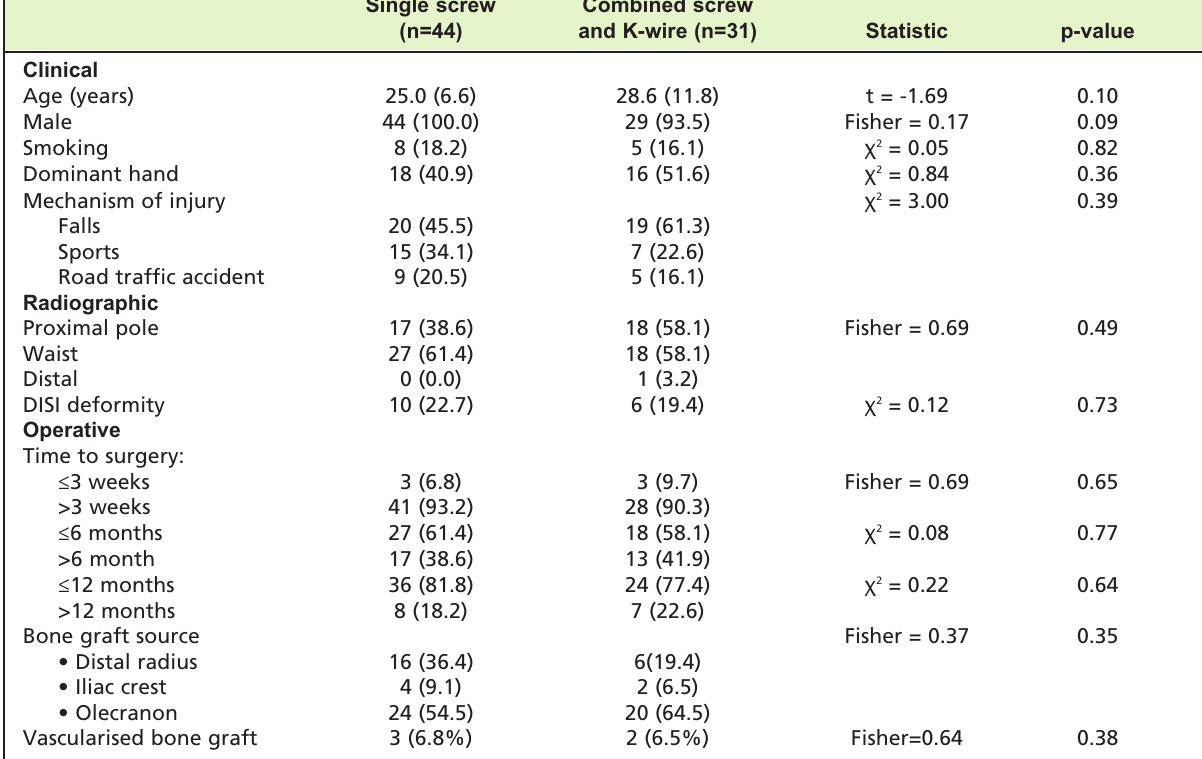
Clinical, radiographic, and operative Table I: